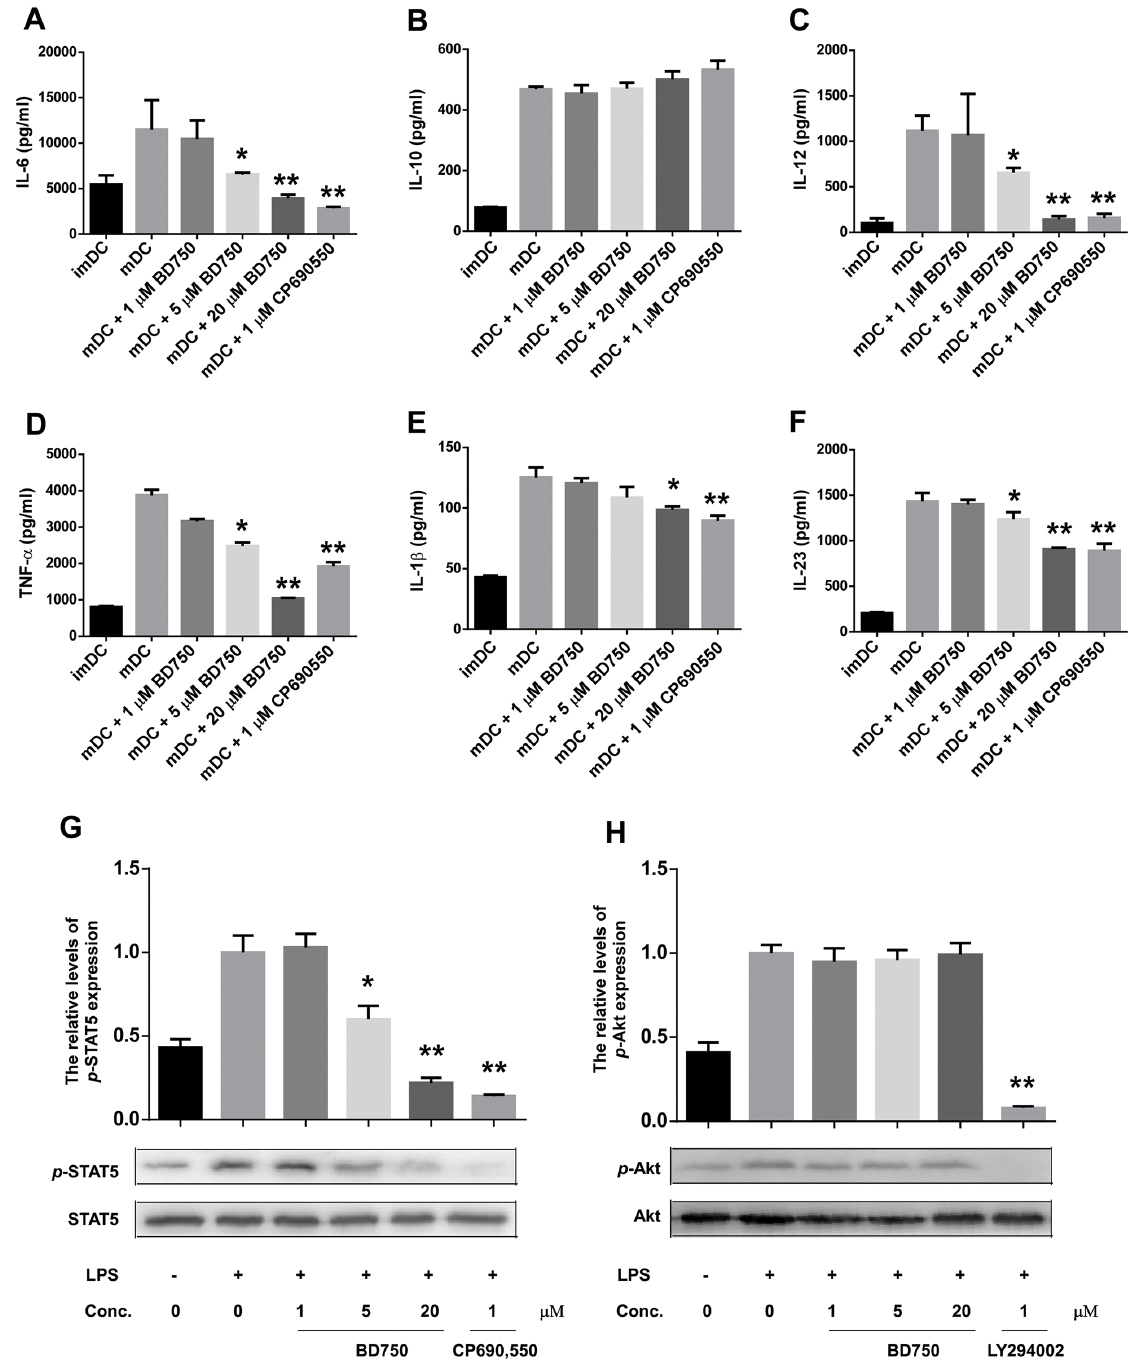
Figure 3. BD750 inhibits proinflammatory cytokine secretion and STAT5 phosphorylation in DCs. BMDCs were stimulated with cytokines for expansion in the presence or absence of BD750 for 12 h and then stimulated with LPS for 24 h. The supernatants of cultured cells were harvested and the levels of IL-6, IL-10, IL-12, TNF- α , IL-1 β and IL-23 in the supernatants were determined by ELISA (A–F). In addition, the relative levels of STAT5 and AKT expression and phosphorylation in the different groups of DCs were determined by Western blot assays (G–H). The relative levels of STAT5 and AKT phosphorylation to total STAT5 and AKT were determined. The relative density for bands of p -STAT5 or p -AKT activity was normalized to the total STAT5 or AKT, respectively. Data are representative images or expressed as the mean ± SEM of three independent experiments. * P < 0.05, ** P < 0.01 versus the mDC